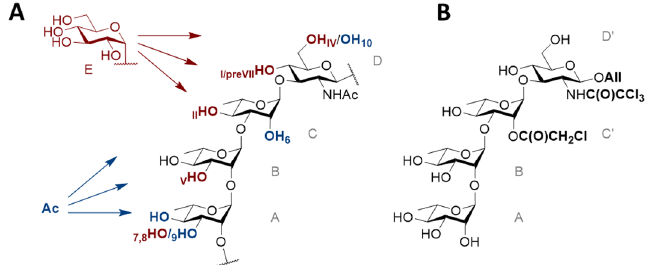
Figure 1. ( A ) Overview of the repeating units of most S. flexneri O-Ags showing the tetrasaccharide backbone ABCD and sites of α -d-glucosylation ( E , in red) and O-acetylation (Ac, in blue) 22 . Each glucosylation pattern is associated to the relevant S. flexneri type-specific (Roman numeral) and group-specific (Arabic numeral) antigenic determinants. ( B ) The lightly protected tetrasaccharide ABC’D’ mimicking ABCD and used in this study as a glucansucrase acceptor substrate to access S. flexneri representative oligosaccharides by a chemoenzymatic route. The chloroacetyl group at OH-2 C paves the way to a hydroxyl group or an acetate (group O-factor 6) as required. The allyl aglycon and 2 D -trichloroacetamide were introduced at an early stage in view of future chain elongation. All free hydroxyl groups are potential sites of enzymatic glucosylation